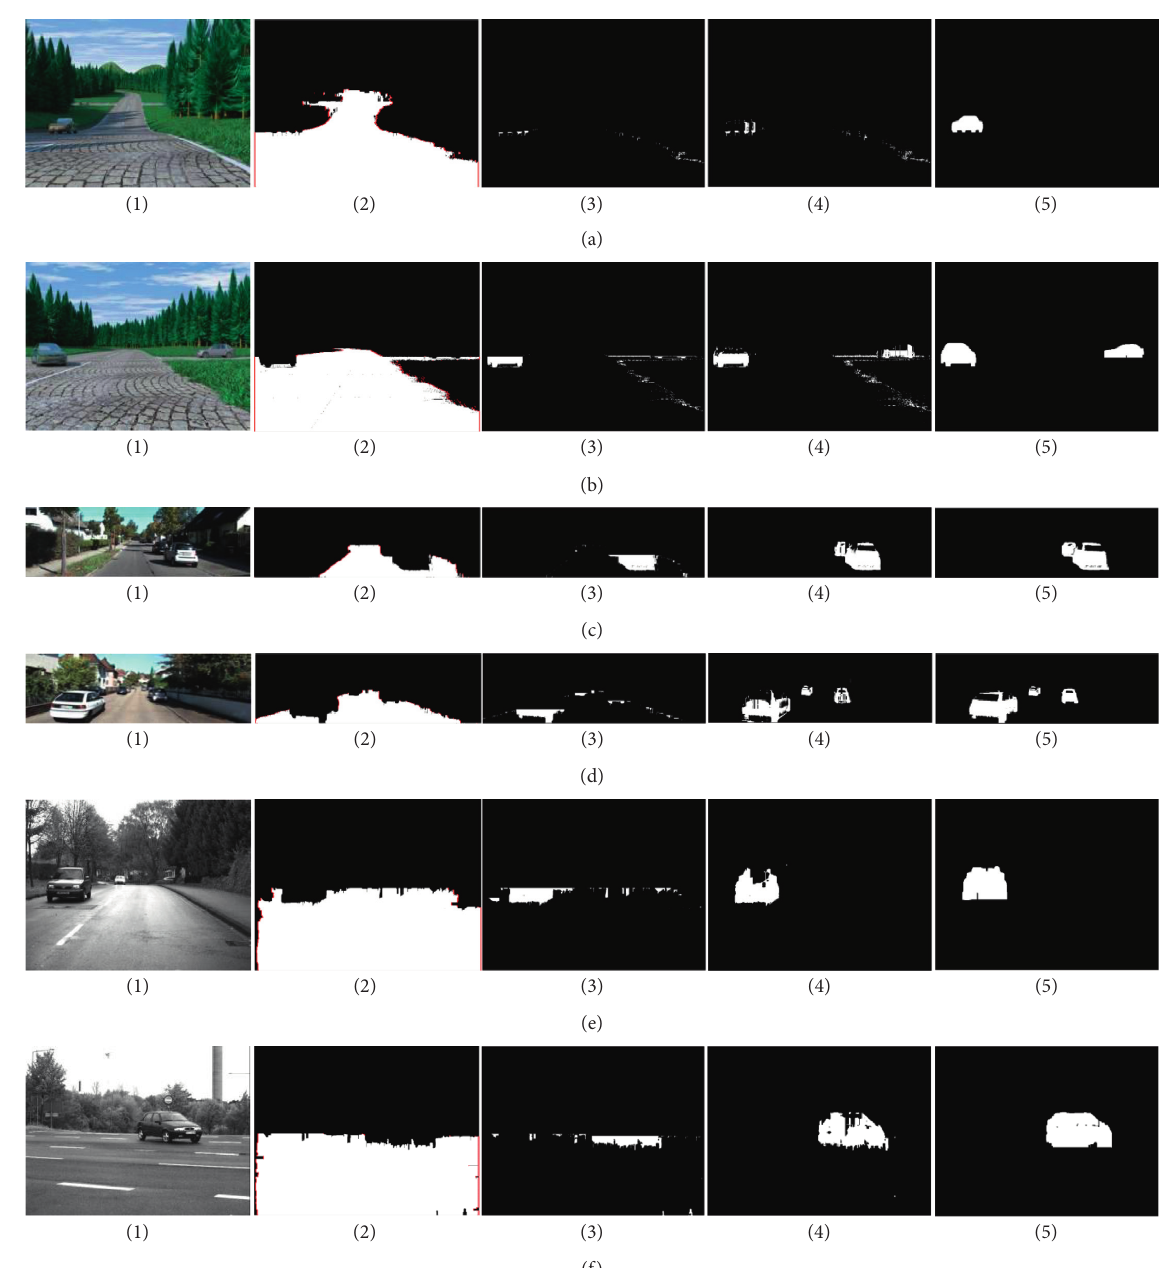
Figure 11: Typical vehicle detection result on the road. (1) Original image (left). (2) Region of interest. (3) Vehicle source point. (4) Initial detection result. (5) Detection